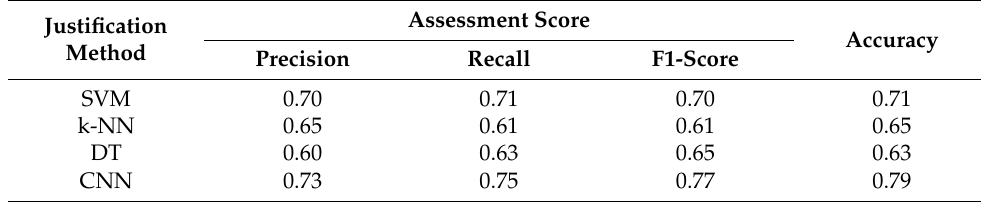
Table 4. Justification results for the proposed landslide susceptibility model.